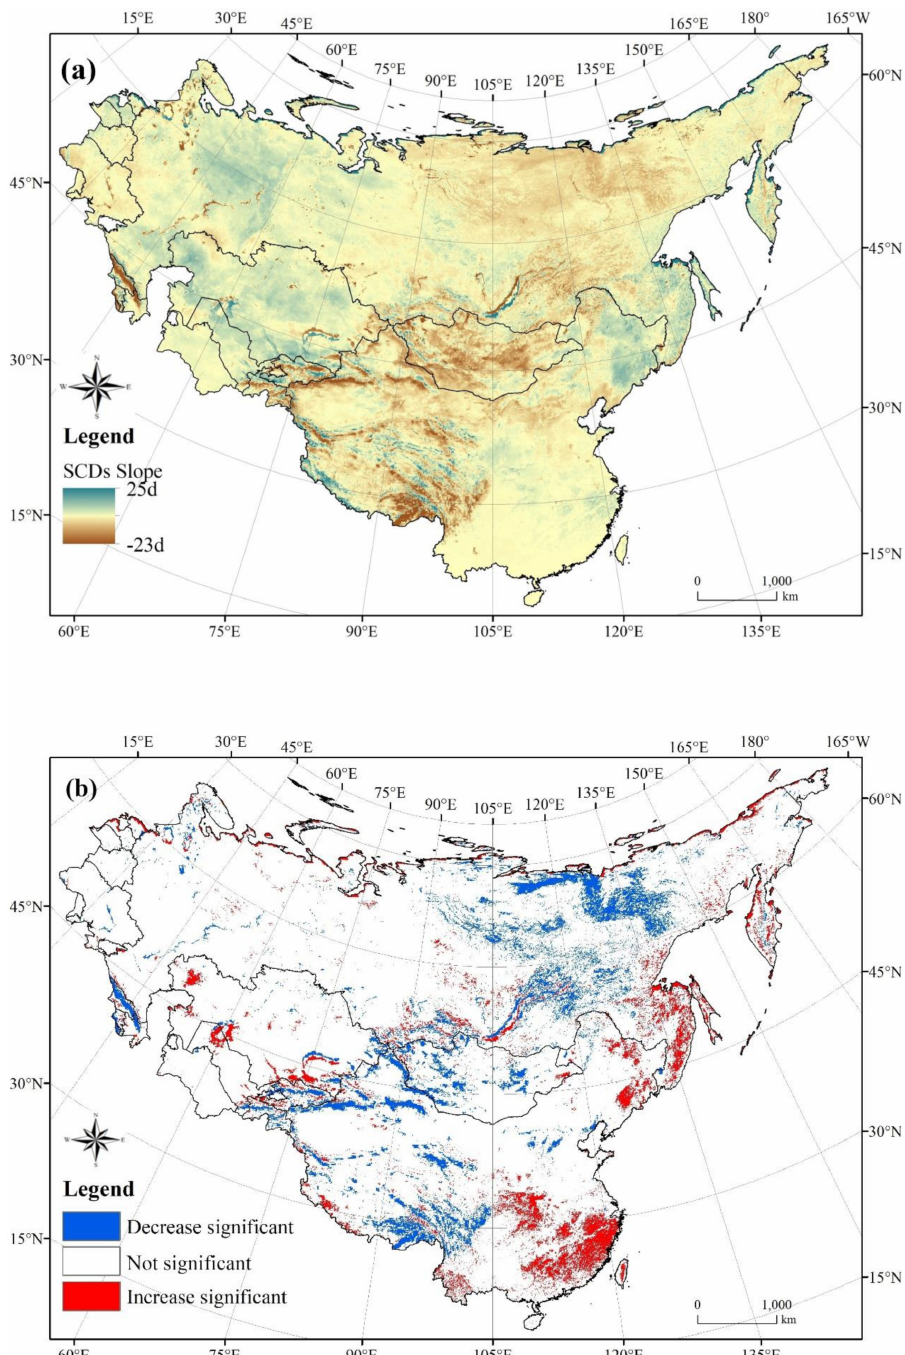
Figure 9. ( a ) The trend of SCDs, and ( b ) the significant test in the study area from 2000 to